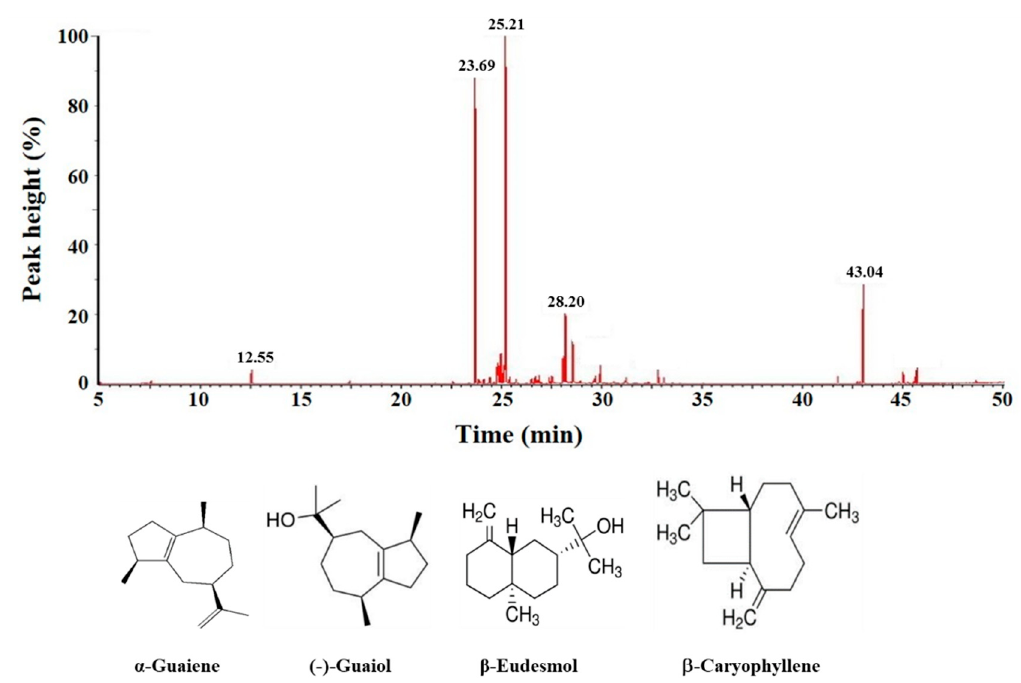
Figure 9. Gas chromatography-mass spectrometry profile of BSE sample and the four ingredients identified from this analysis. These four compounds were confirmed by comparing with their mass spectral data with the NIST mass spectral library and commercially available products.